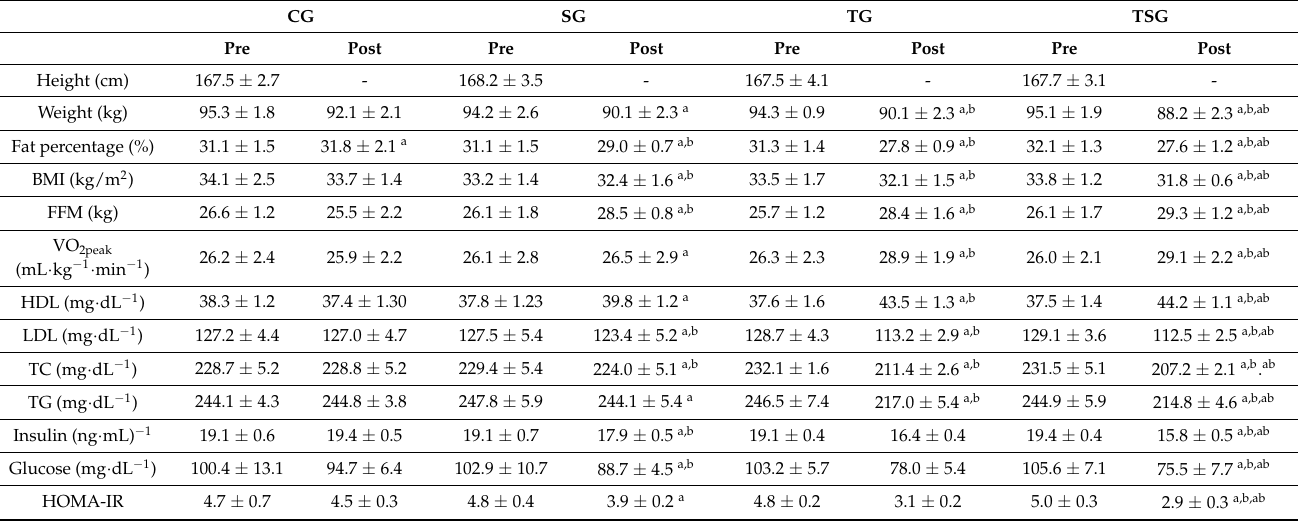
Table 2. Mean ( ± SD) values of glucose, insulin, lipid profile, body composition, and VO 2peak